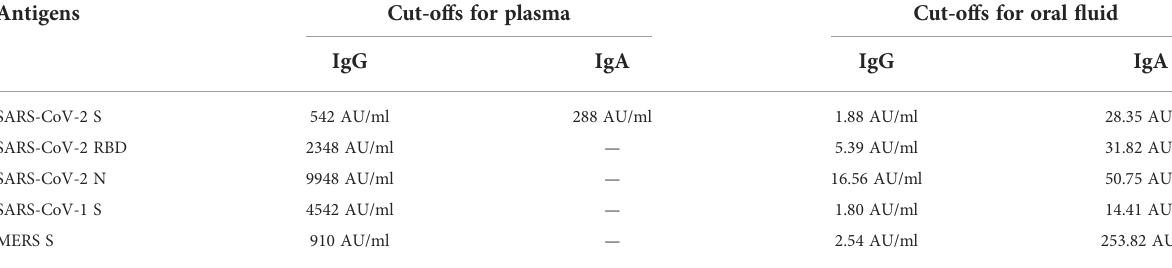
TABLE 2 Cut-offs for plasma and oral fl uid samples determined for the MSD ® IgG and IgA immunoassays.